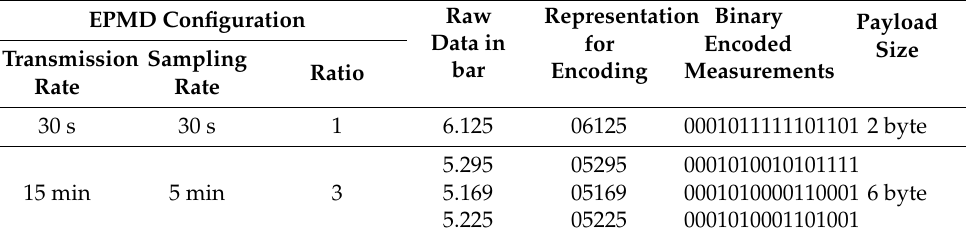
Table 1. Example for binary encoding of monitored pressure data.